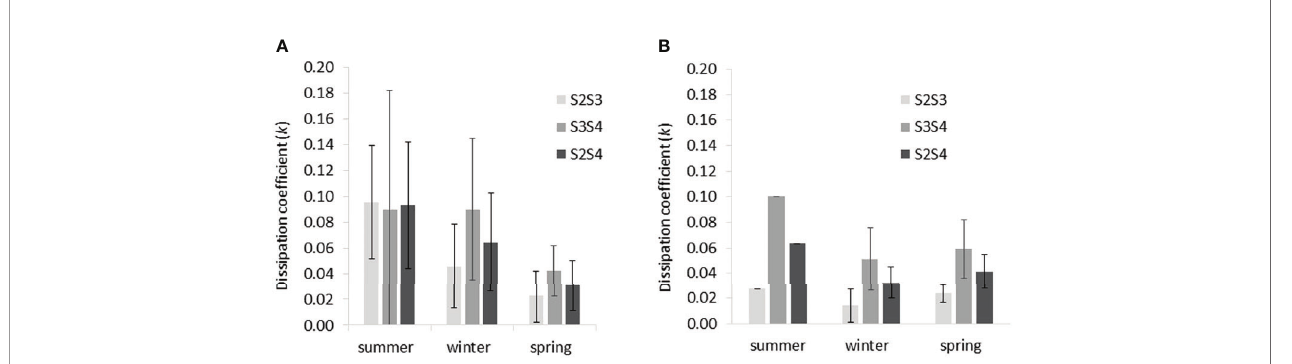
FIGURE 5 | Relationship between relative wave height (Hs/h) and total spectral energy dissipation [(Jm -1 ) for (A) Cape Dolosman (three different onshore wind directions; linear regression line for winds approaching shore-normal to within ± 10 degress (solid black dots) is shown] and (B) all conditions with onshore (± 30 deg) winds at Histria (second order polynomial regression fi t shown).